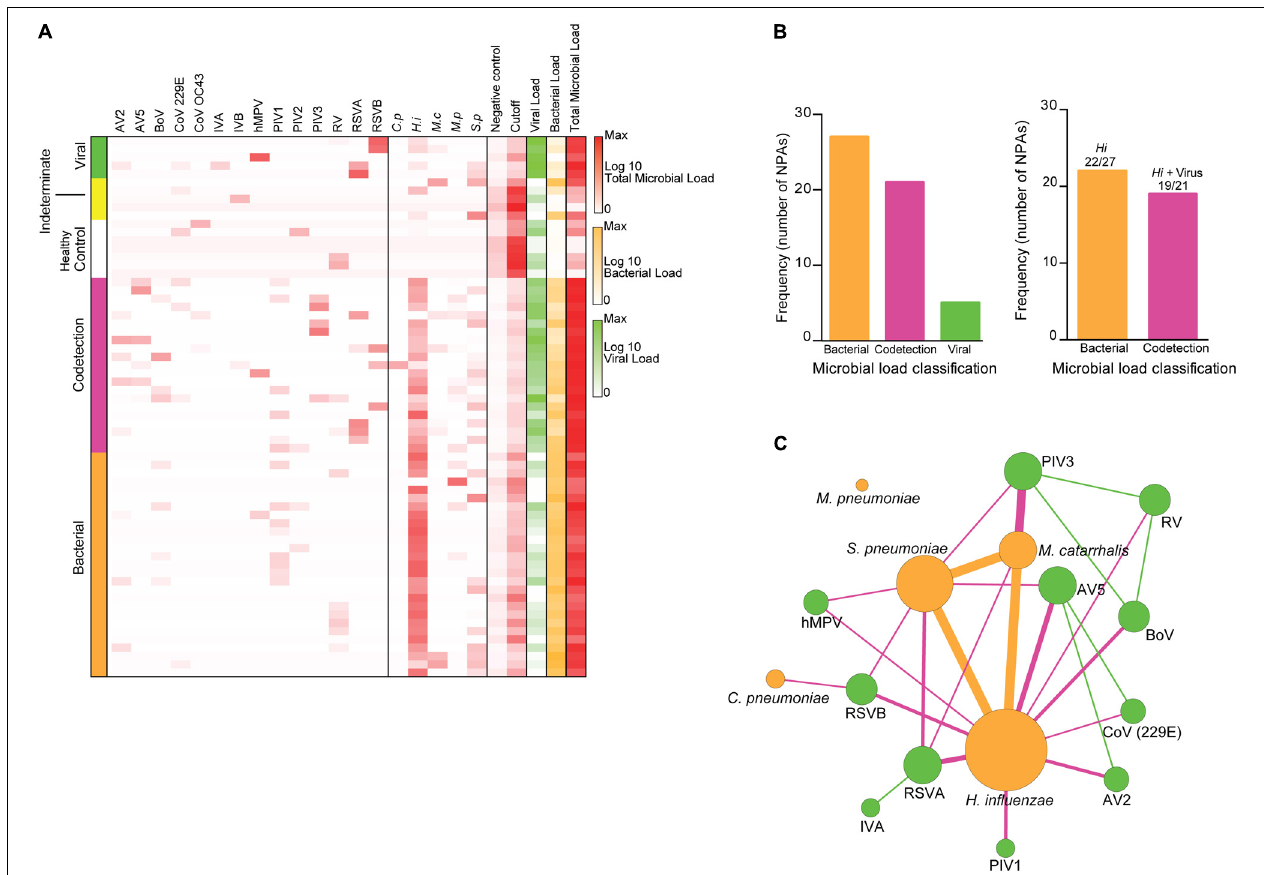
FIGURE 1 | Microbial composition of nasopharyngeal aspirates of children with ARI. Nasopharyngeal aspirates (NPAs) ( n = 53) were subjected to transcriptomics analysis using a set of probes targeting adenovirus (AV 2 and 5), bocavirus (BoV), coronavirus (CoV 229E and OC43), parainfluenza virus (PIV 1, 2, and 3), respiratory syncytial virus (RSVA and B), influenza virus (IV A and B), human metapneumovirus (hMPV), and rhinovirus (RV), Haemophilus influenzae , Streptococcus pneumoniae , Mycoplasma pneumoniae , Moraxella catarrhalis , and Chlamydia pneumoniae. (A) Heatmap depicting the number of pathogen transcripts (Log10) for each NPA; NPAs were classified according to the microbial load: Viral (green), Codetection [presence of both viral and bacterial transcripts) (pink)], and bacterial (orange). Control NPAs were obtained from healthy subjects (See Materials and Methods and Supplementary Dataset 1 for details). (B) Frequency of NPAs classified according to the microbial load classification (left). Frequency of NPAs presenting H. influenzae transcripts in NPAs classified as bacterial or codetection. (C) Association network depicting associations among the different microbial targets detected in NPAs. Size of circle indicates node degree and line width indicates correlation